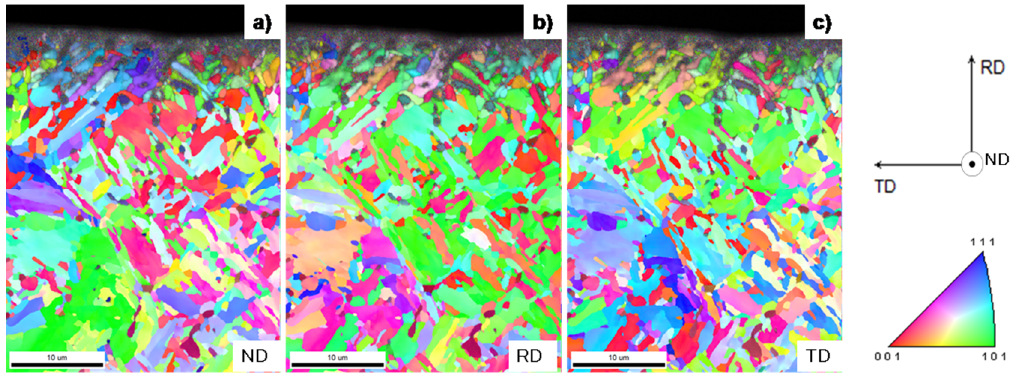
Figure. 7 . Inverse pole figure (IPF) distribution on the cross-section of nitrided AISI420 at 673 K for 3.6 ks in three directions; ( a ) IPF in the normal direction (ND); ( b ) IPF in the rolling direction (RD); ( c ) IPF in the tangential direction (TD).